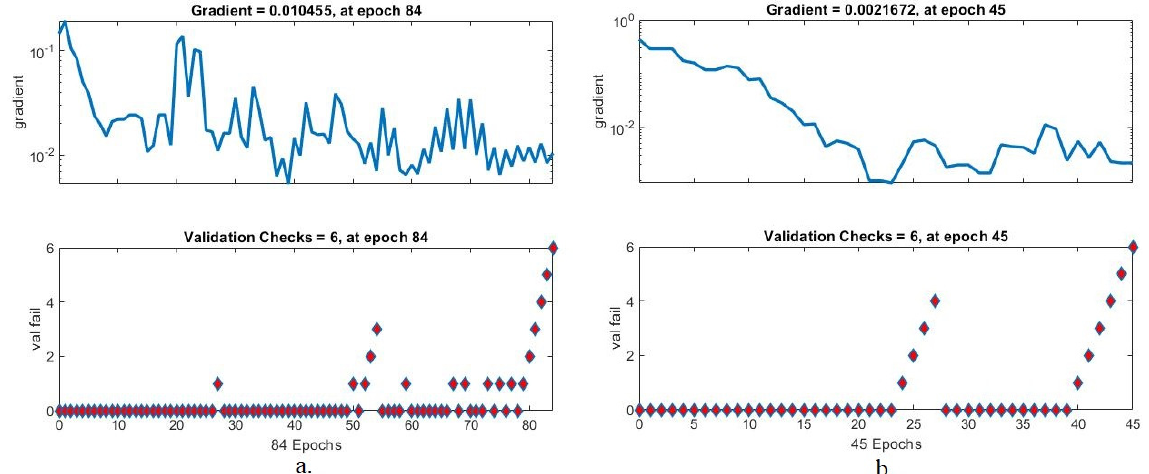
Figure 12. Display gradient for diagnosing abnormal cell images of the cervix by ANN based on the features of ( a ). VGG ‐ 16, FCH, GLCM and LBP ( b ). GoogLeNet, FCH, GLCM and LBP.